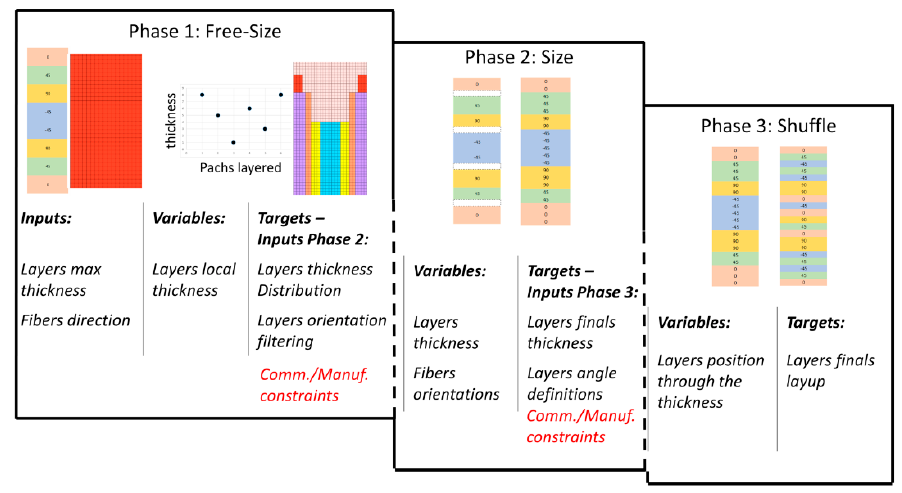
Figure 1. Composite laminate optimization process [22].